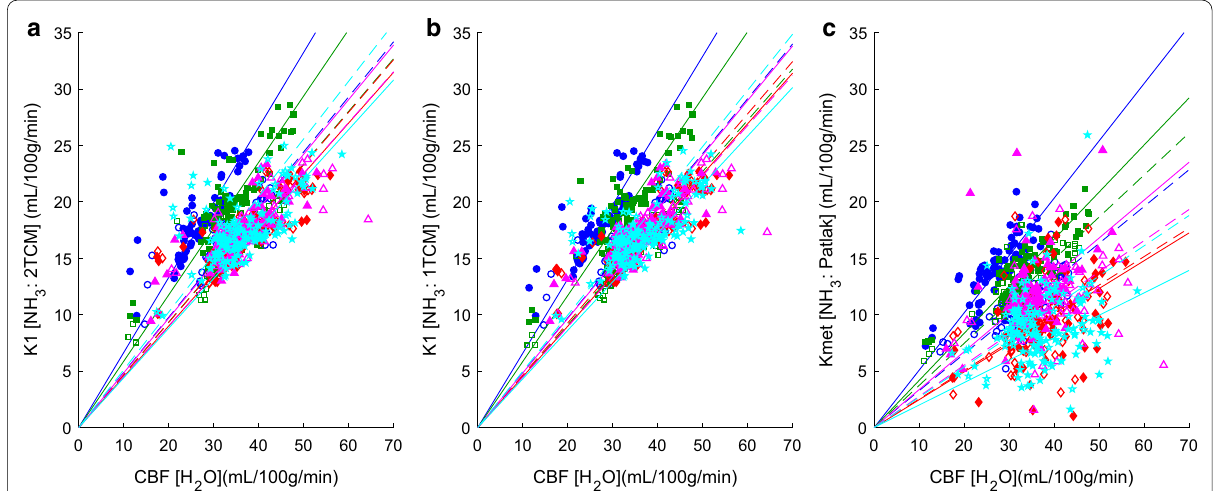
Fig. 3 CBF vs K 1 correlations. Plots showing association across 78 ROIs of K 1 ( y -axis) from model fits of [ 13 N]ammonia data with CBF ( x -axis) from paired [ 15 O]H 2 O scans within each subject (1–5) and for scans 1 and 2. Lines show line of best fit (zero intercept). Subjects 1–5 are coded with symbol type and colour. Solid symbols and solid lines show scan 1, open symbols and dashed lines scan 2. a K 1 calculated from irreversible 2TCM; b K 1 calculated from reversible 1TCM; c K met calculated from Patlak plot. CBF is calculated using the Meyer [27] model described in the